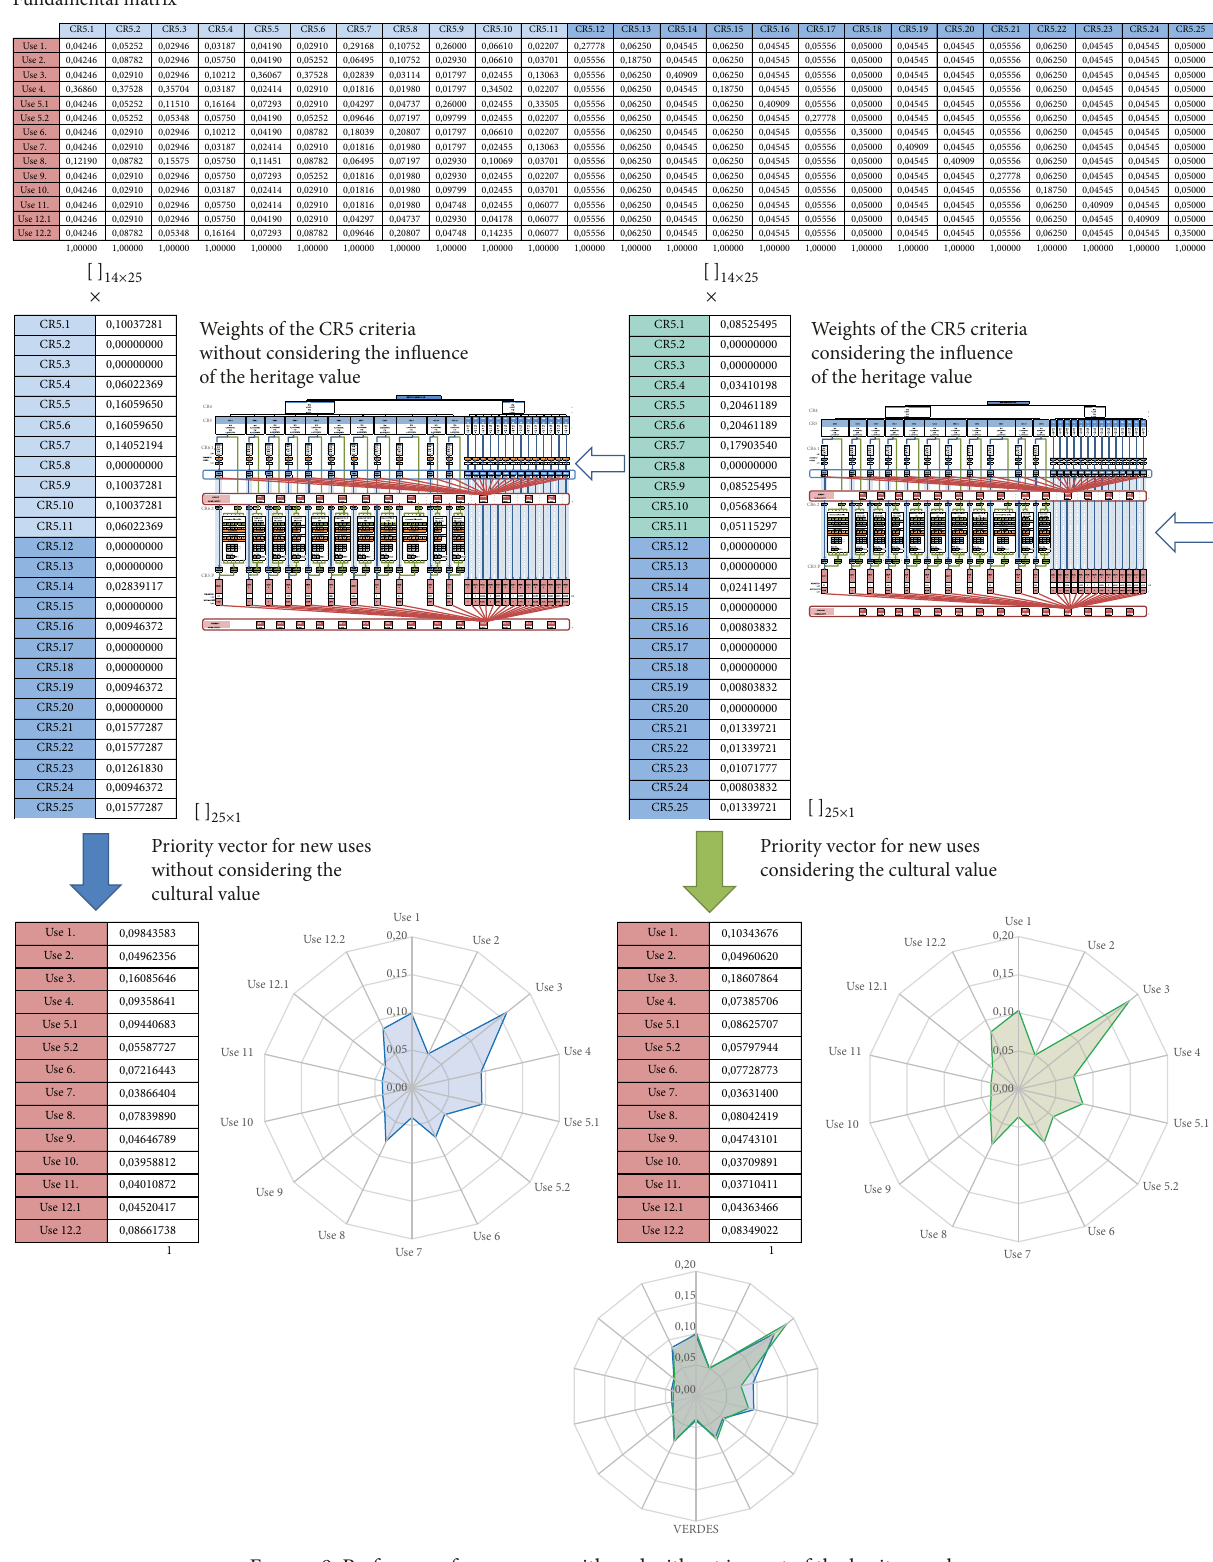
Figure 9: Preferences for new uses with and without impact of the heritage